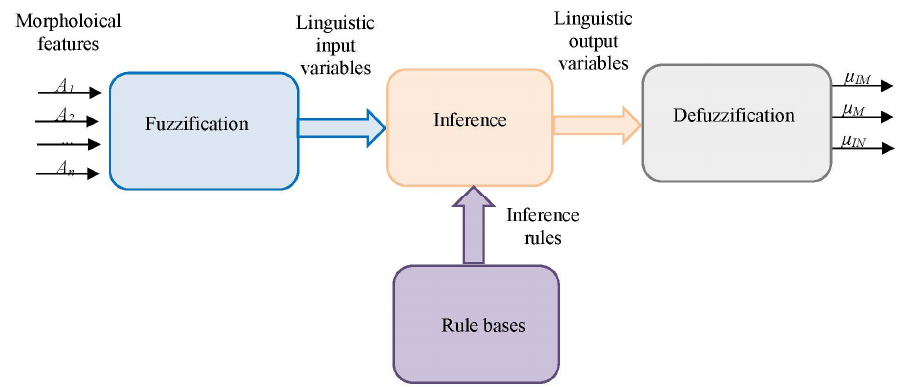
Figure 4. Block diagram of the fuzzy classification system.